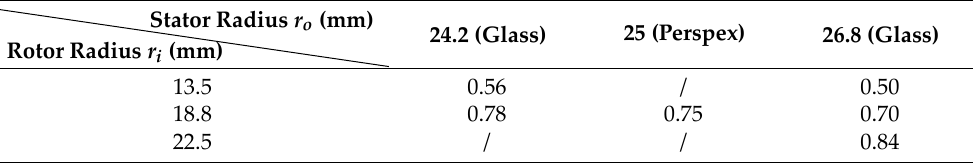
Table 2. Employed geometries, defined by the radius ratio 𝜂 . The length of the apparatus was held constant at 𝐿 = 594 mm.